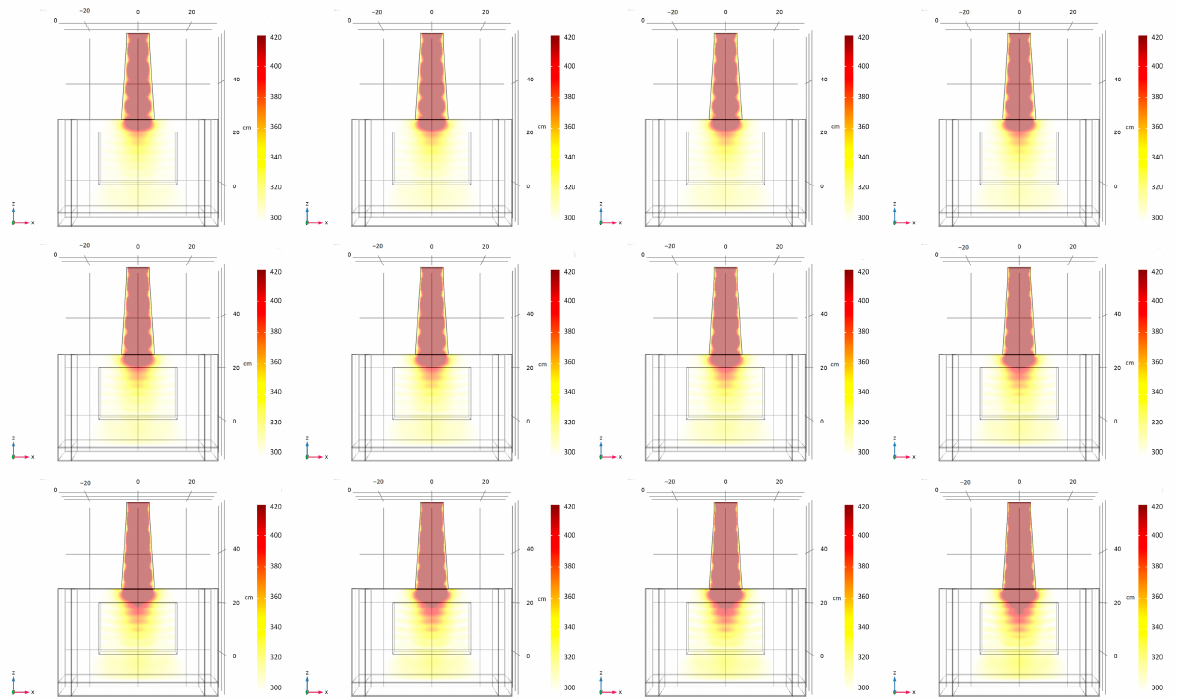
Figure 5. Temperature variation law of the microwave-irradiated soil model.